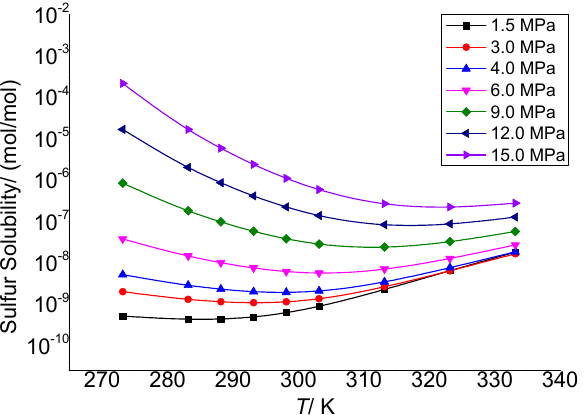
Figure 3. Solubility curve of elemental sulfur in acid gas 3 with temperature.